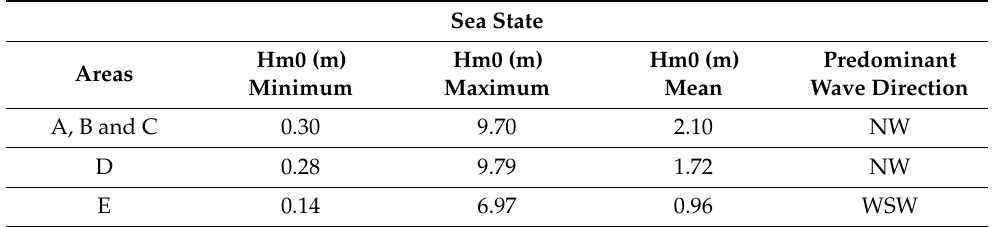
Table 6. Minimum, maximum, and mean of the significant wave height (Hm0) (m) and predominant wave direction in the areas